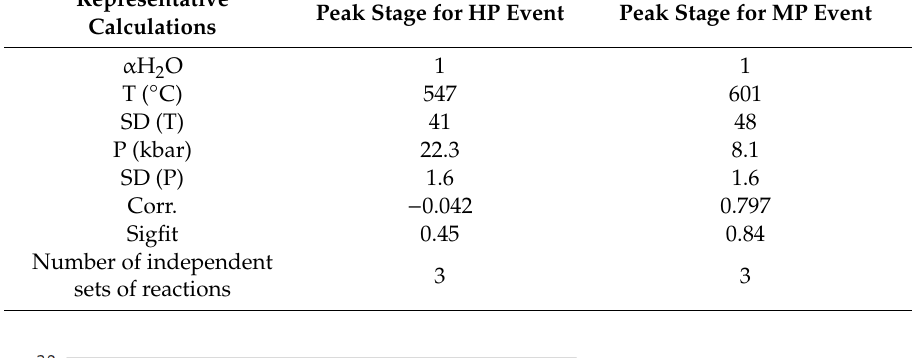
Table 5. Representative THERMOCALC calculations for peak stages for HP and MP events Representative